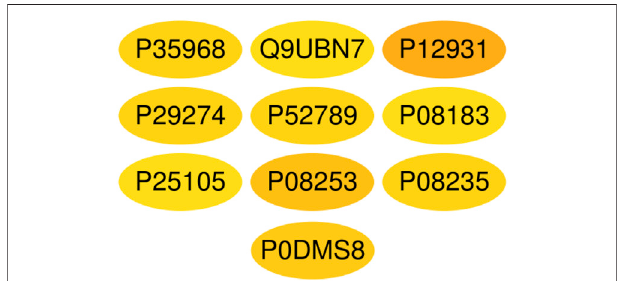
FIGURE5| Top10Hub targetgenesofHIRIobtained throughthe MCC function. The color gradually changes from yellow to red; the closer to the red target gene, the more important itis. They are, respectively,P15692 (VEGFA), P05231 (IL-6), P01375 (TNF), P02768 (Alb), P05412 (Jun), P42574 (Casp3), P04406 (GAPDH), MAPK3 (P27361), P35354 (PTGS2), and MMP9 (P14780).